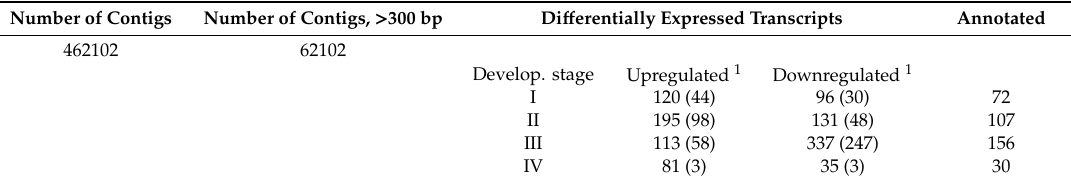
Table 2. Numbers of di ff erentially expressed transcripts at each of four ovule developmental stages. Number of Contigs Number of Contigs, > 300 bp Di ff erentially Expressed Transcripts Annotated 462102 62102 Develop. stage Upregulated